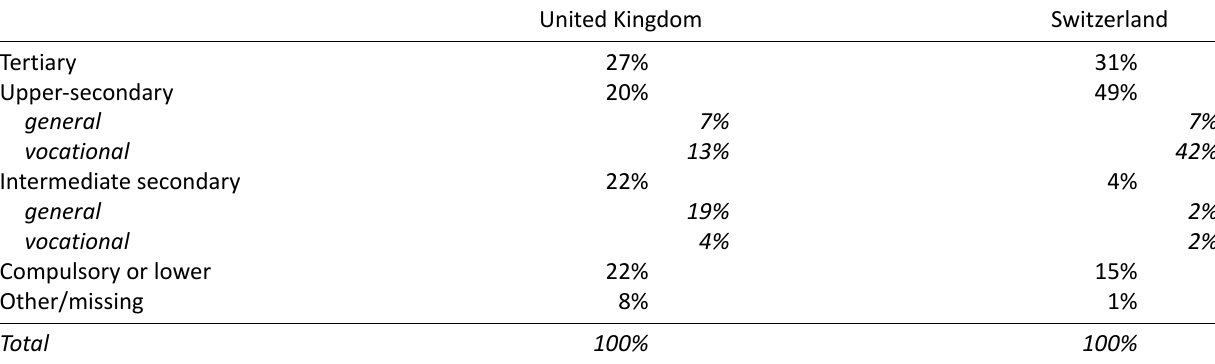
Table 1. Distribution of the population aged 25 to 60 across education in the United Kingdom and in Switzerland, cohort born